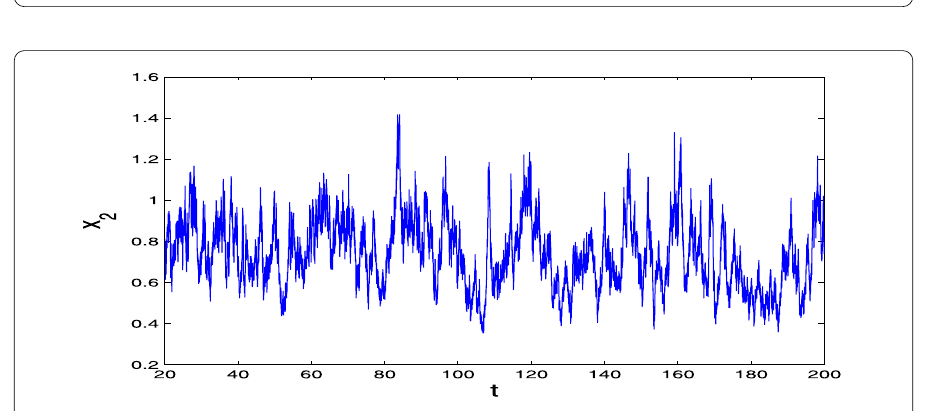
Figure 2 Stochastic trajectory of x 2 ( t ) for system (61) with σ 1 (1) = 0.2, σ 1 (2) = 1.0, σ 2 (1) = 0.2, σ 2 (2) =